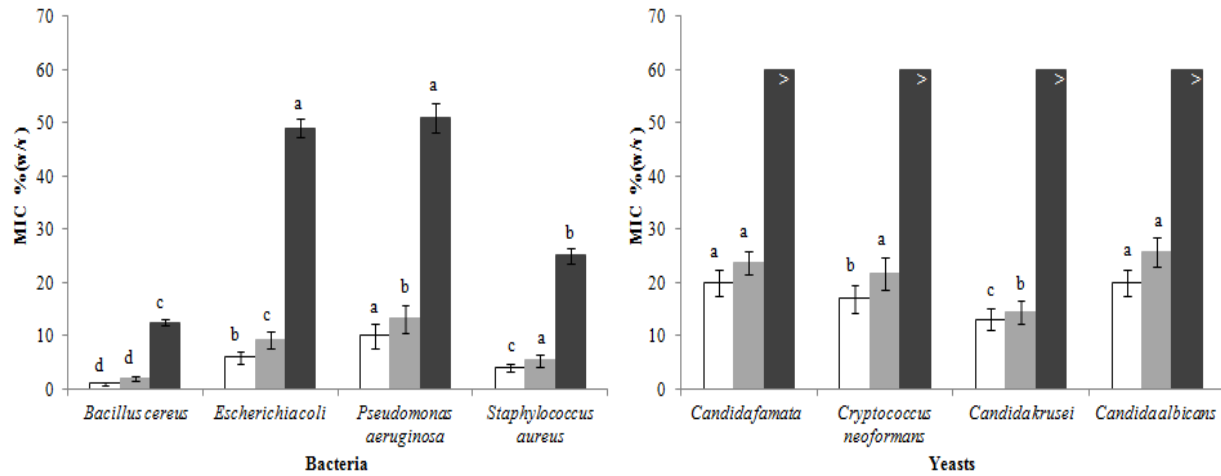
Gram positive bacteria ( B. cereus sp., S. aureus sp.), Gram negative bacteria ( E. coli sp. and P. aeruginosa sp.) and yeasts ( C. famata sp., C. neoformans sp., C. krusei sp., C. albicans sp.). Figure 1. Minimum inhibitory concentration of honey (n = 25): without catalase ( □ ), with catalase ( ■ ), artificial honey ( ■ ); against four bacteria ( Bacillus cereus sp., Escherichia coli sp., Pseudomonas aeruginosa sp. and Staphylococcus aureus sp.) and four yeasts ( Candida famata sp., Cryptococcus neoformans sp., Candida krusei sp. and Candida albicans